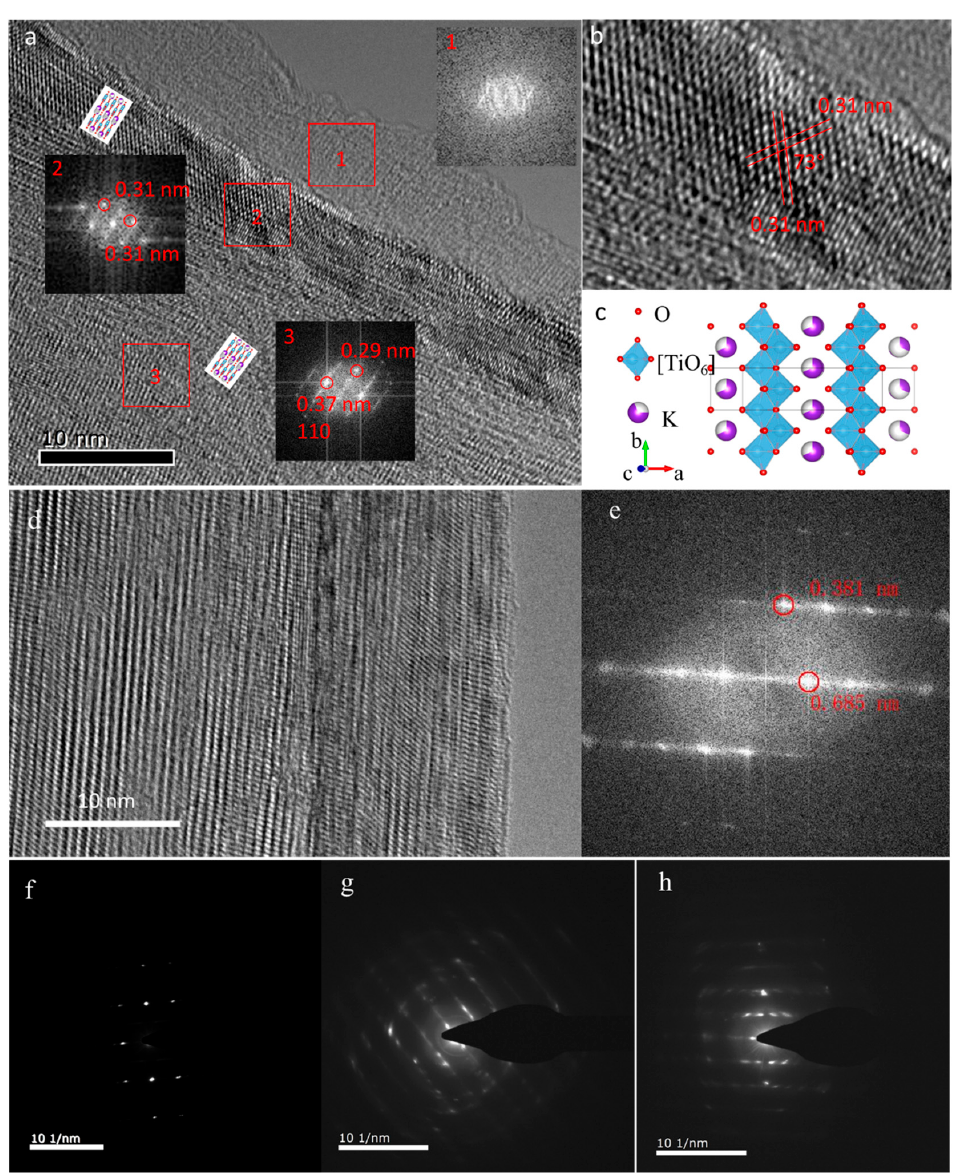
Figure 4. ( a ) HRTEM images of K 2 Ti 8 O 17 electrode after charge–discharge cycling tests in aqueous AlCl 3 electrolyte. ( b ) Magnified HRTEM image taken from red square box region 2 in ( a ). ( c ) Crystal structure of the layered K 2 Ti 8 O 17 . ( d ) HRTEM image and ( e ) corresponding FFT image of crystal structure of the layered K 2 Ti 8 O 17 after cycling in the AlCl 3 /NaAc electrolyte for 100 cycles. SAED images of the layered K 2 Ti 8 O 17 electrode, ( f ) pristine sample, ( g ) measured in the AlCl 3 electrolyte, and ( h ) measured in the AlCl 3 /NaAc electrolyte.